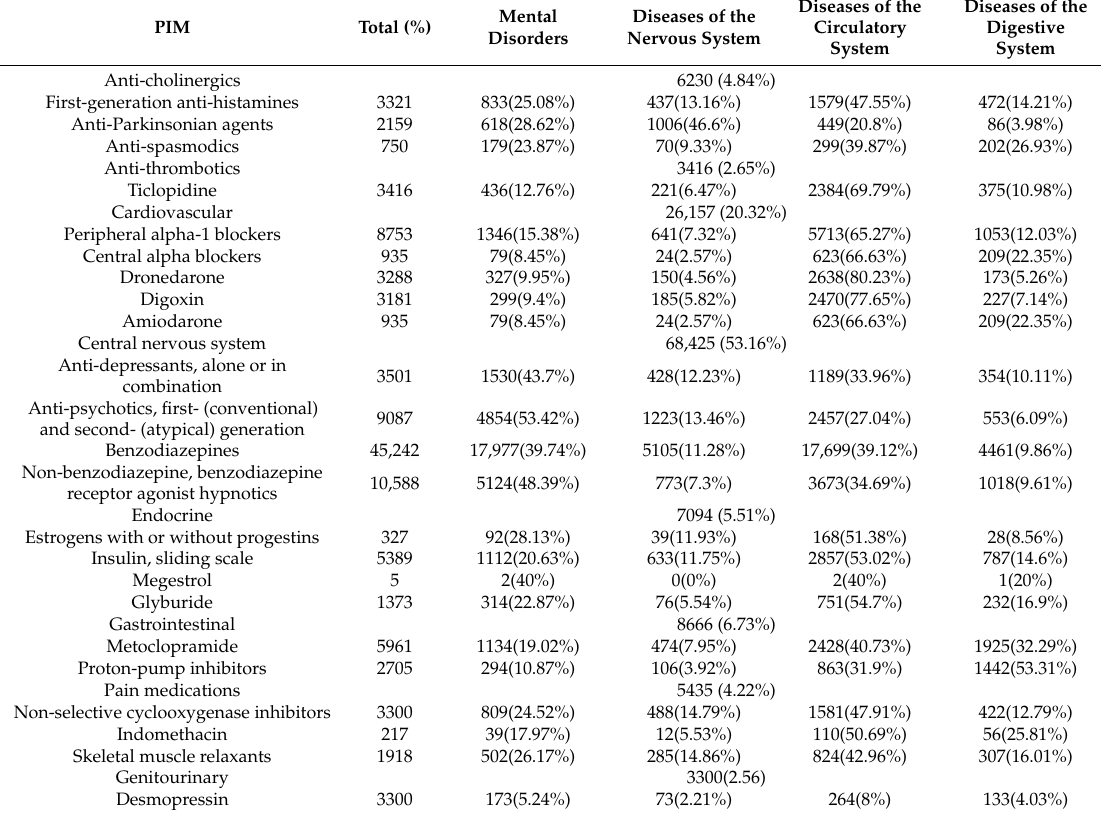
Table 3. Distribution of long-term continuous exposure to PIM in certain chronic diseases. PIM Total (%)